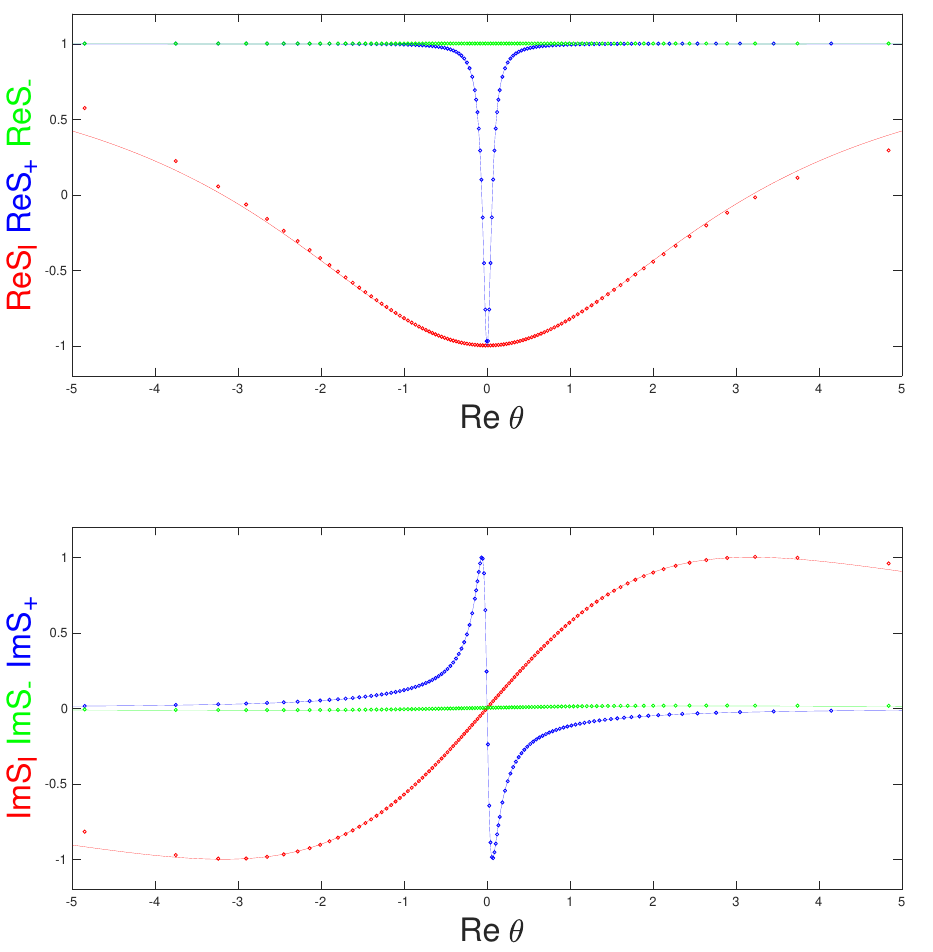
Figure 6. The comparison of the maximization results with the exact integrable model for N = 100. We use 200 points for interpolation and choose an initial functional F = Re[ S 1 ( (cid:18) 0 ) (cid:0) (cid:11)S 2 ( (cid:18) 0 )] with (cid:18) 0 ’ i ( z 0 = 0 : 3 i ) and (cid:11) = 2 : 4. Here we plot the real and imaginary parts of S I , S + and S (cid:0) on the physical line where the dots indicate maximization results while the curves are the exact integrable